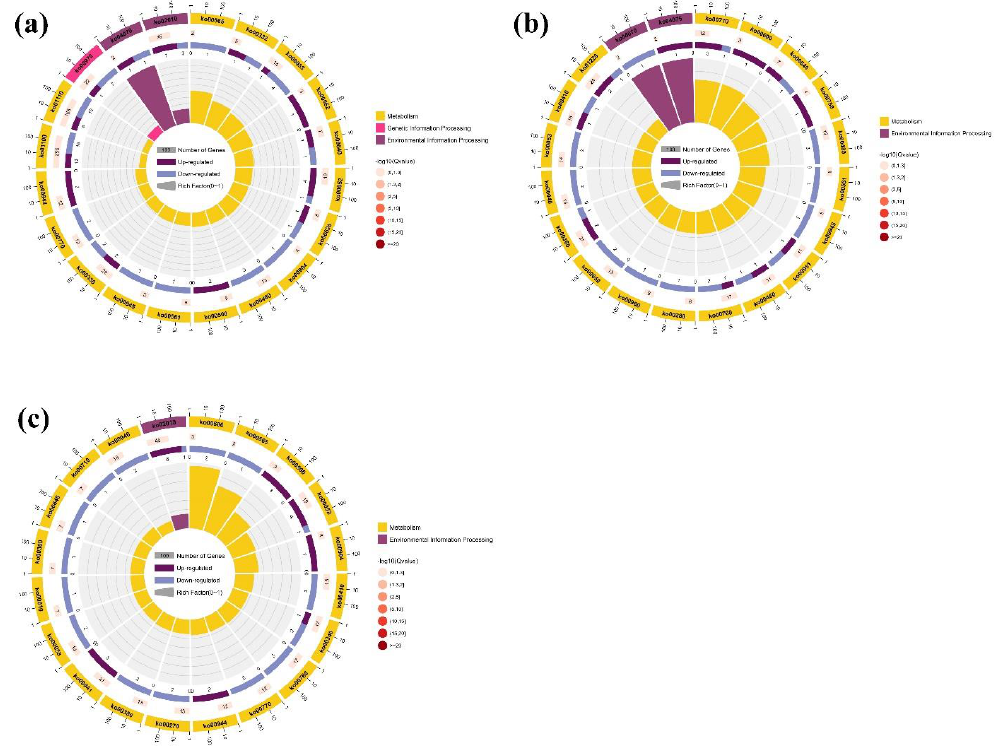
Figure 8. KEGG enrichment circle diagram. ( a ) Group A vs. Group K; ( b ) Group A vs. Group G; ( c ) Group G vs. Group K.